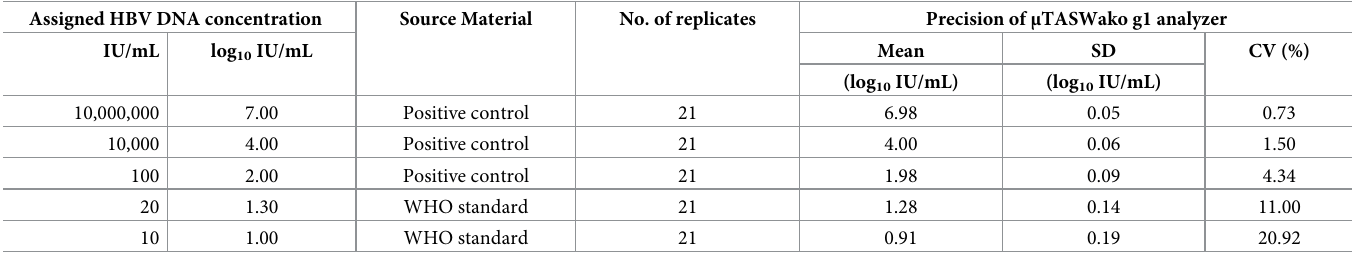
Table 2. Precision of μ TASWako g1 analyzer. Assigned HBV DNA